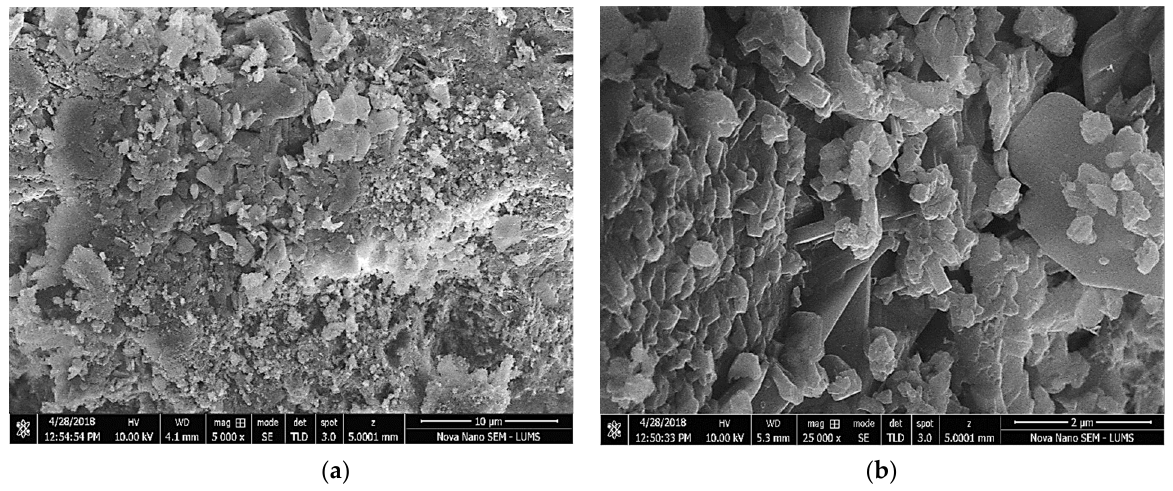
Figure 8. SEM images of specimens incorporating 30% of AP. ( a ) 10 µm (5000× mag.) ( b ) 2 µm (25,000× mag.). (mag. = magnification).